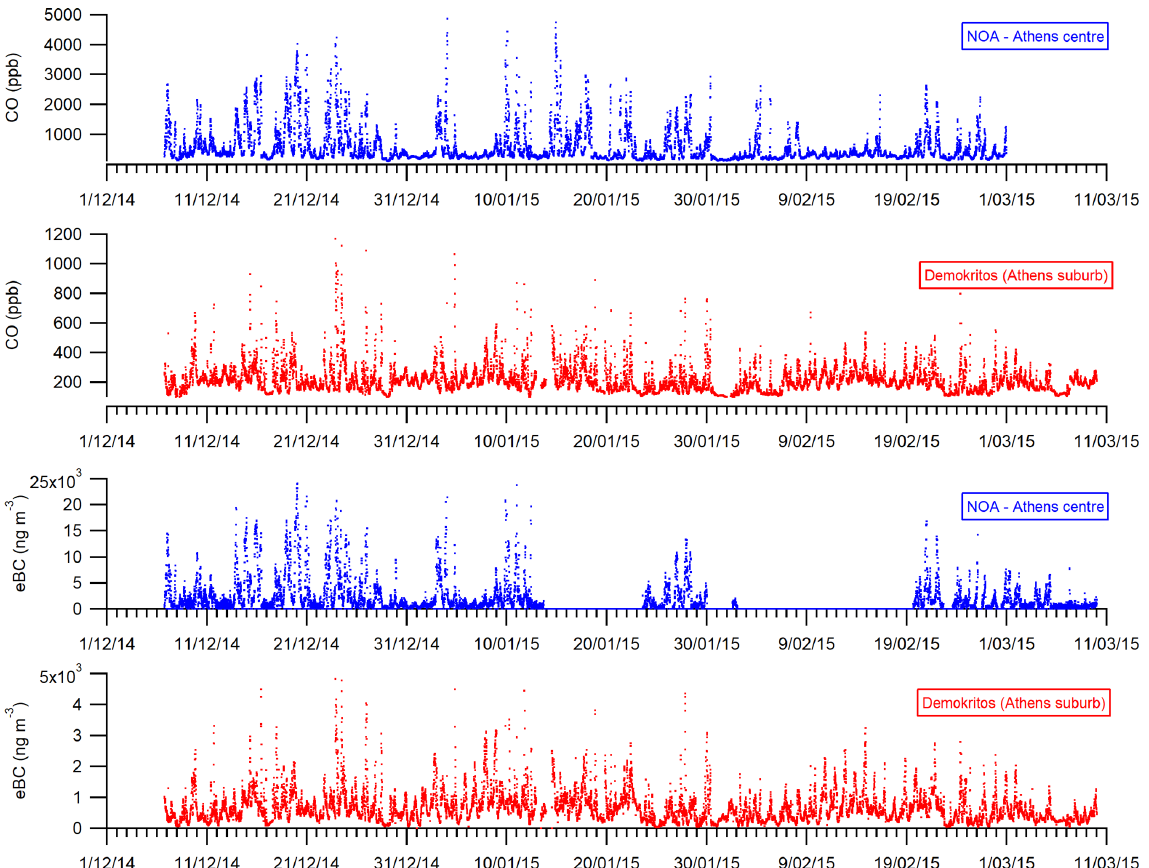
Figure 2. Time series of 10min averaged CO and eBC concentrations measured at NOA (in blue) and DEM (red) monitoring stations from 6th December 2014 until 10th march 2015.